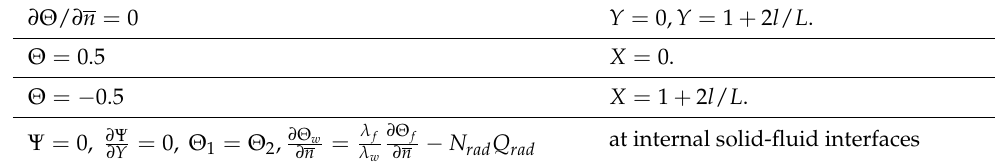
Table 3. Border limitations.